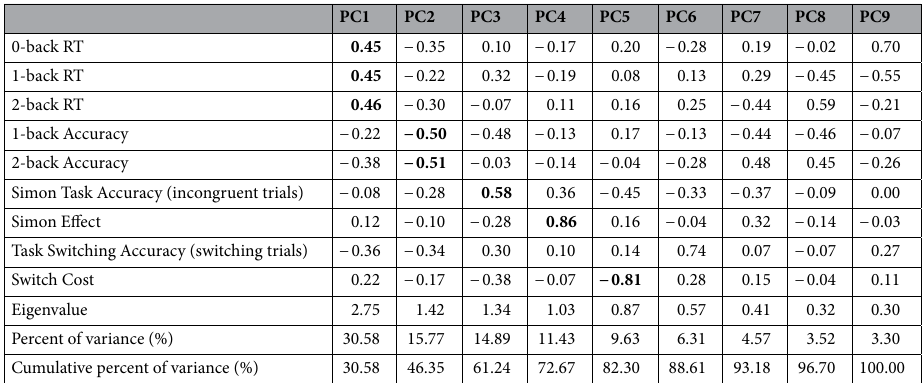
Table 2. Loadings for the principal component analysis of the executive function data. The loadings of main compositions were marked bold.